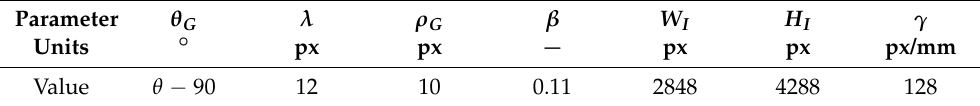
Table 4. G ABOR filter parameters used for image filtering and image